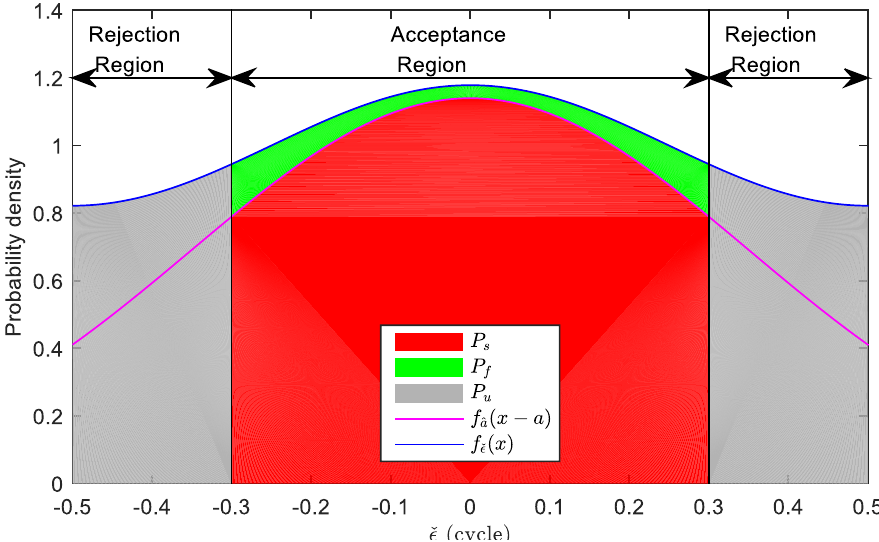
Figure 1. The area of the red region, the green region, and the grey region corresponds to P s , P f and P u .